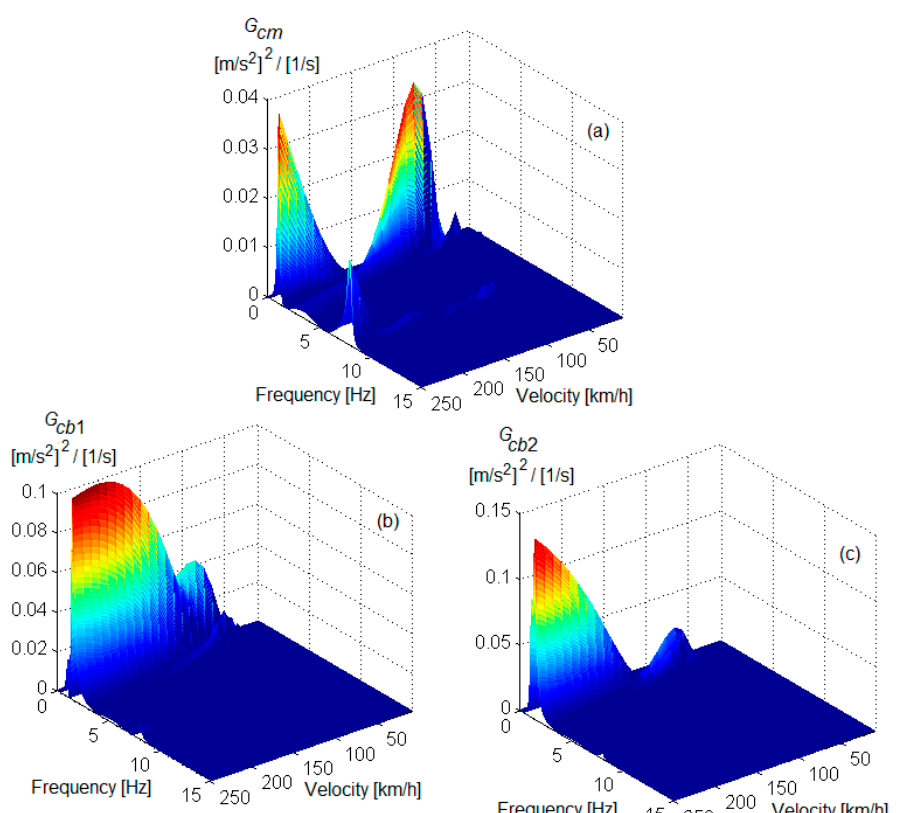
Figure 2. The power spectral density of the carbody acceleration: ( a ) at the carbody centre; ( b ) against the front bogie; ( c ) against the rear bogie.